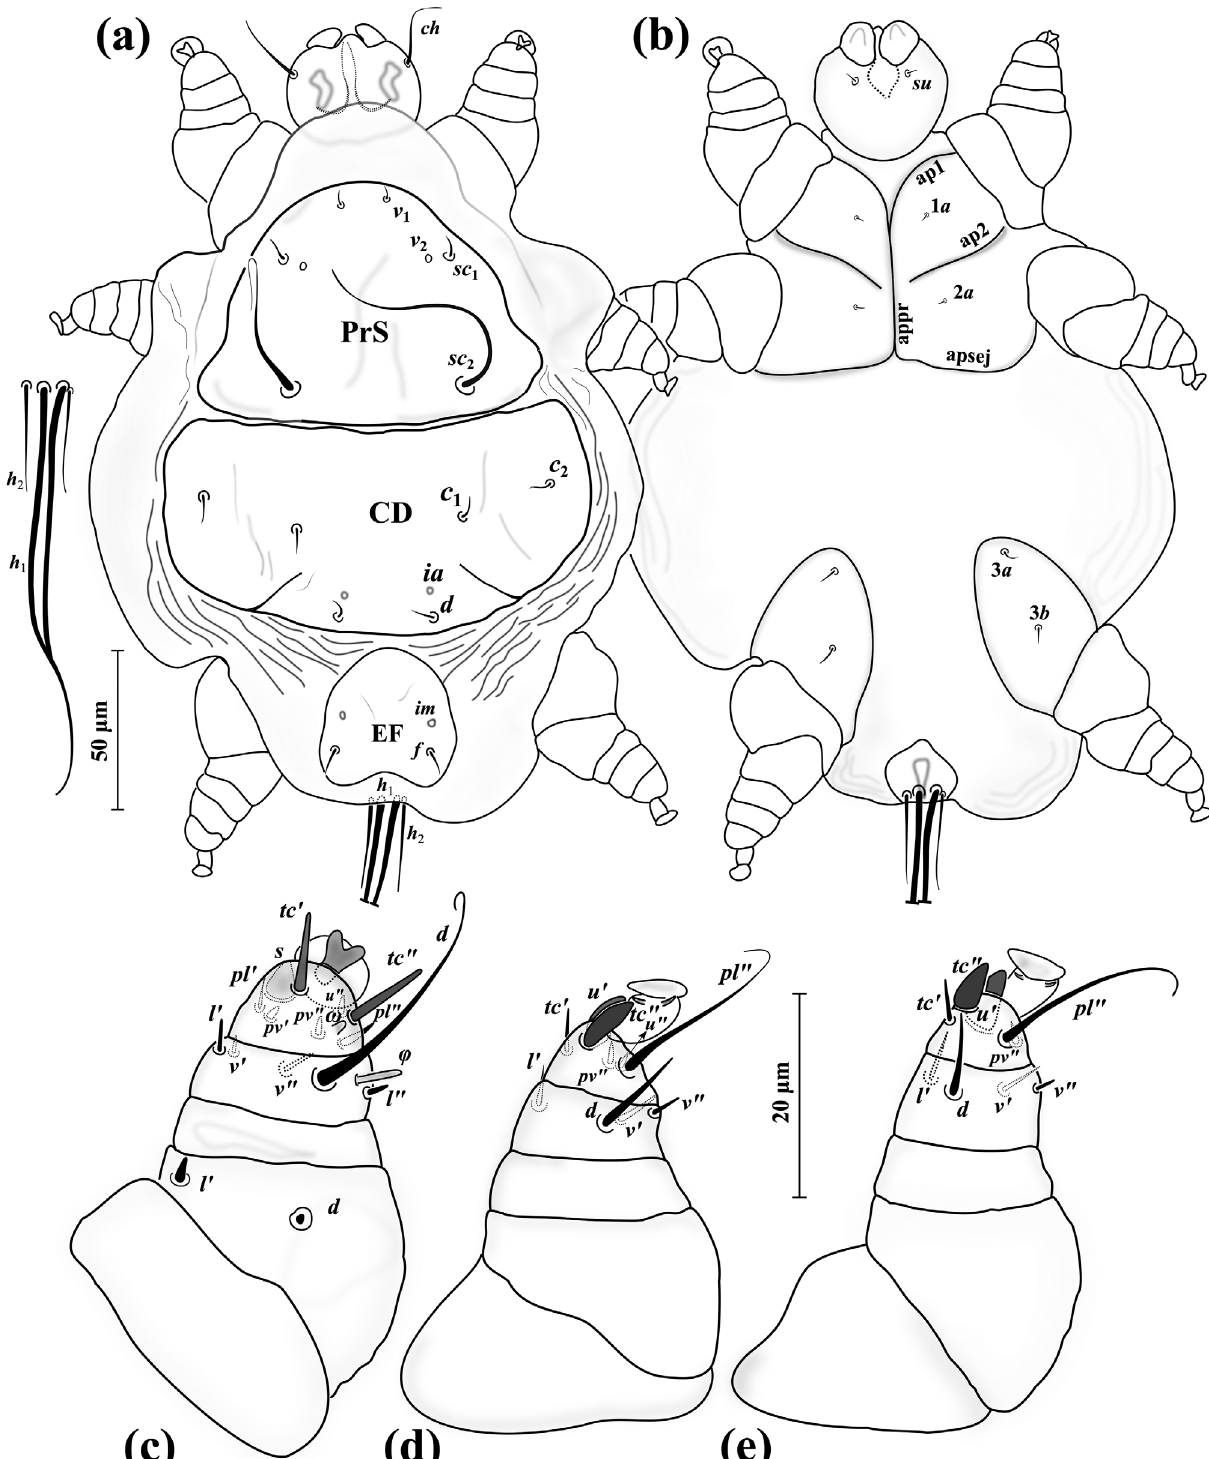
Figure 3. Eutarsopolipus paryavae n. sp. (larval female). (a) Body dorsum; (b) body venter; (c) right leg I; (d) right leg II; (e) right leg III. All legs in dorsal